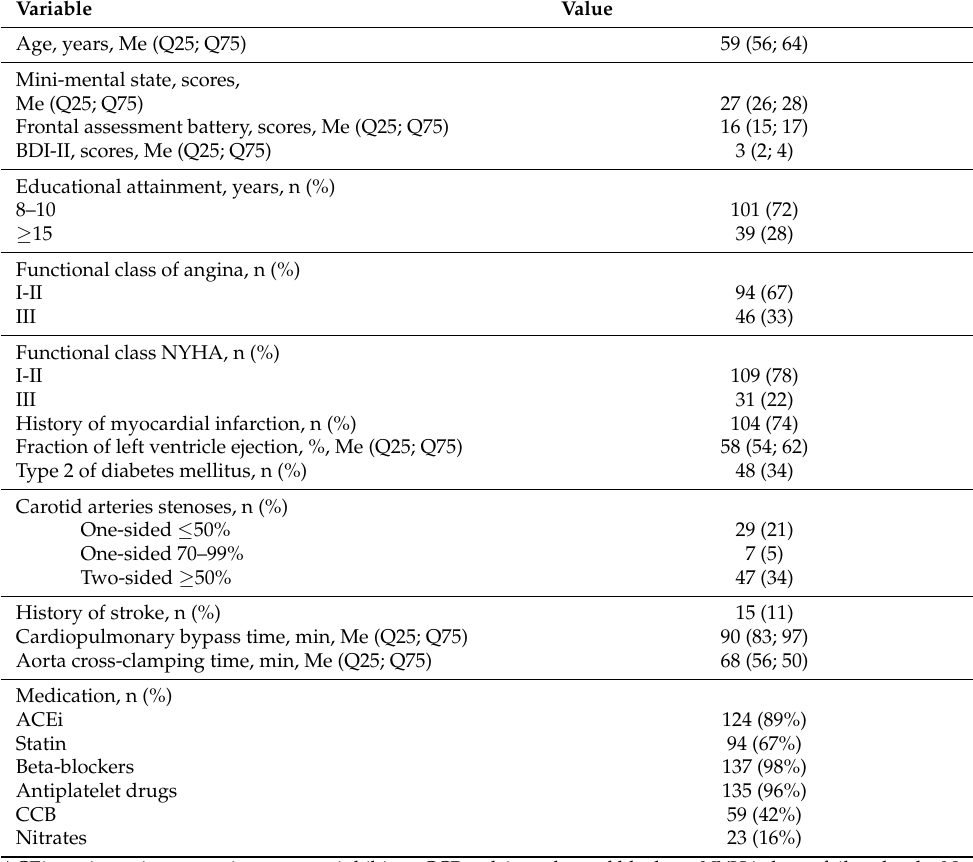
Table 1. The clinical and anamnestic characteristics of the patients before cardiac surgery (n = 140).